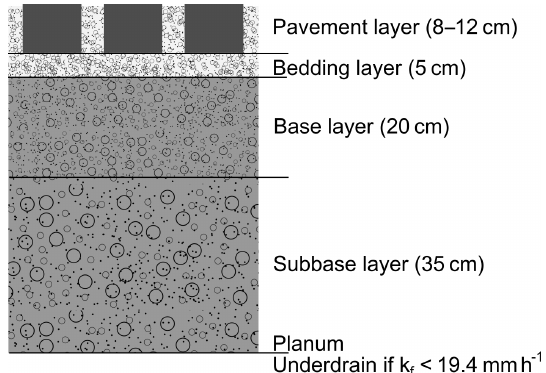
Figure 2. Monthly precipitation sum and mean air temperature re- coded at the climate station DWD within the study period compared to long-term mean values. The light grey background indicates the winter half year.